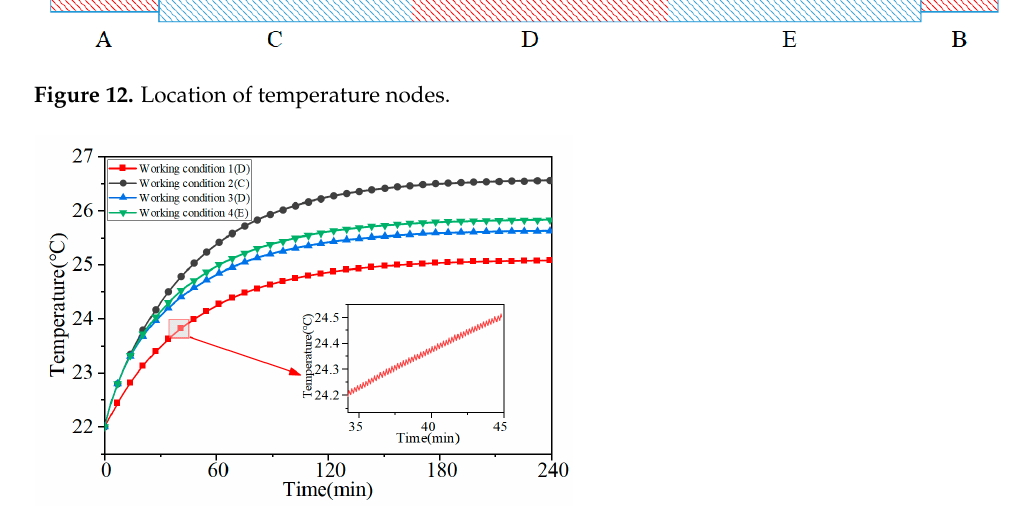
Figure 13. Nodes temperature change in operating interval under different working conditions.